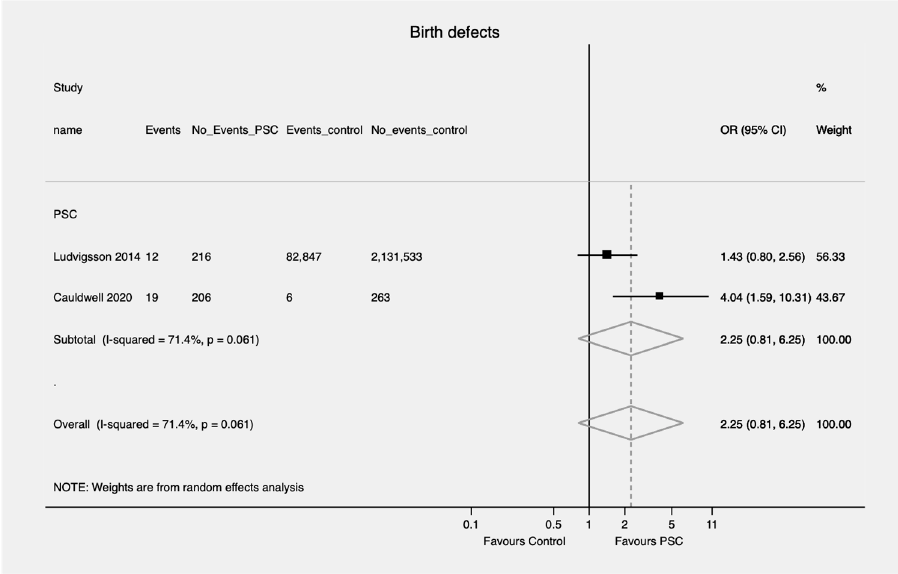
Figure 2. Preterm birth (the event) in patients with PBC and PSC compared to controls. PBC—Pri- mary biliary cholangitis; PSC—Primary sclerosing cholangitis; OR—Odds ratio; CI—Confidence in- terval.